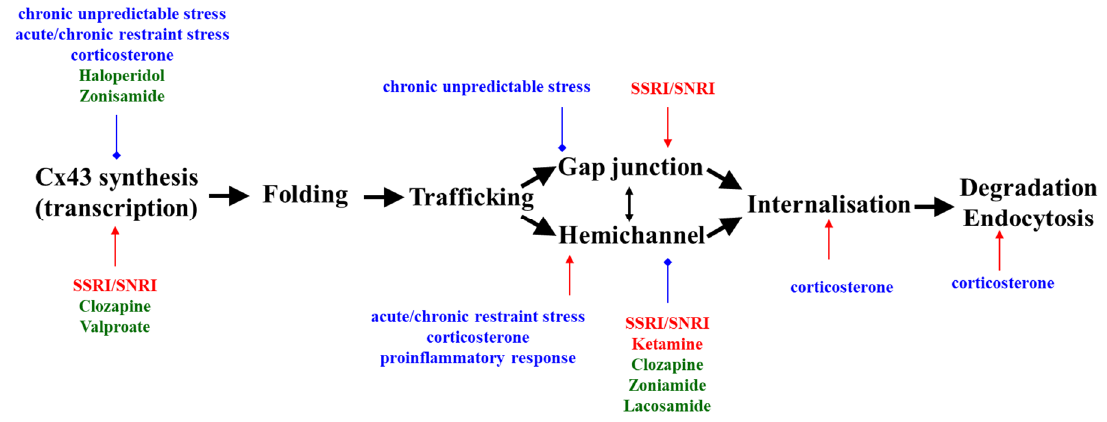
Figure 1. Summary of the effects of antidepressants (red), mood stabilisers (green), and depressive mood-inducing stress (blue) on astroglial Cx43. Red and blue arrows indicate stimulatory and inhibitory effects, respectively. Cx43: connexin43, SSRI: selective serotonin re-uptake inhibitor, SNRI: serotonin norepinephrine reuptake inhibitor.